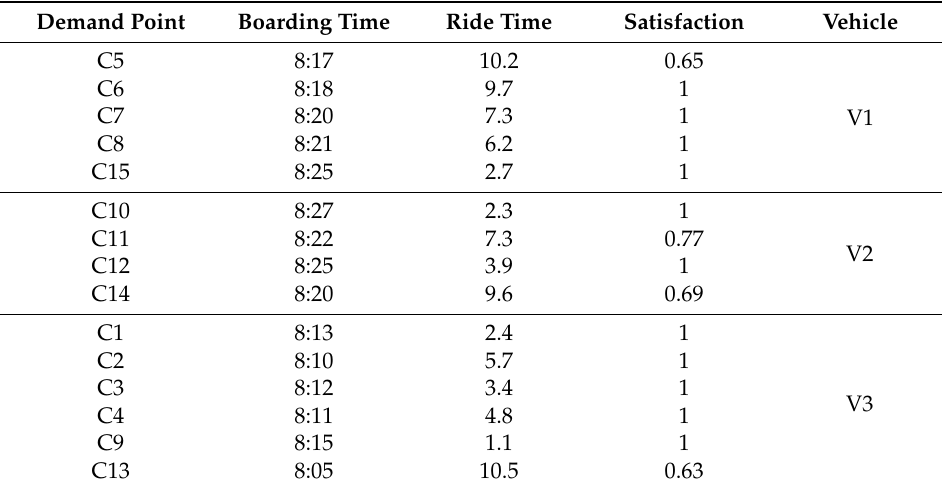
Table 3. Assignment result of passengers picked up by